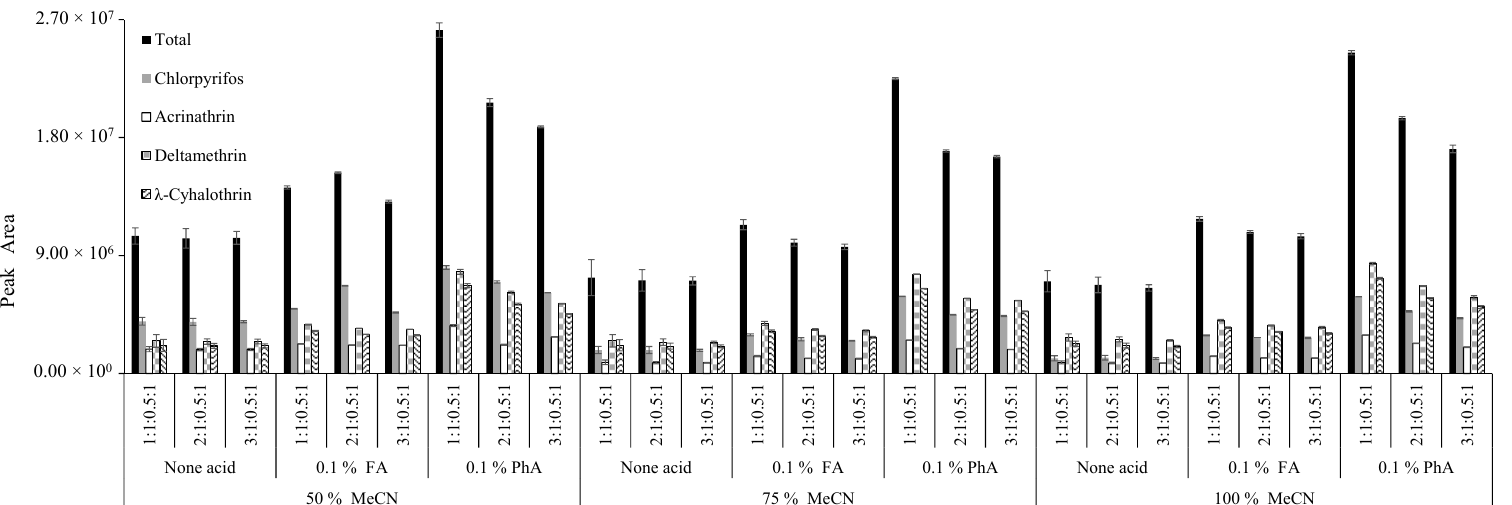
Figure 2. Influence of acetonitrile (MeCN), acidification (none, 0.1% FA and 0.1% PhA) and partition salts ratio in the extraction step for each studied insecticide. Abbreviations—FA: formic acid; PhA: phosphoric